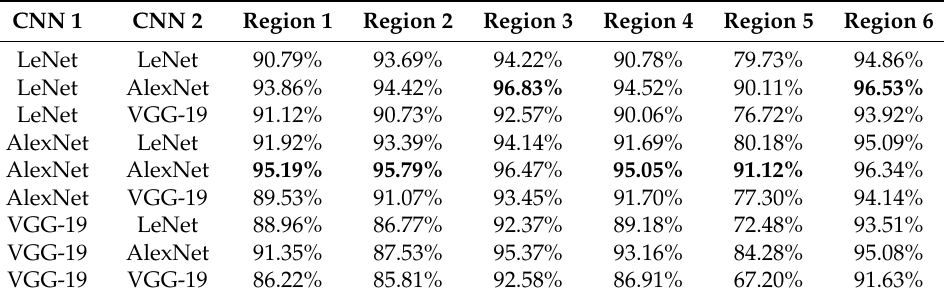
Table 2. The F1-score of six selected regions obtained from different CNN